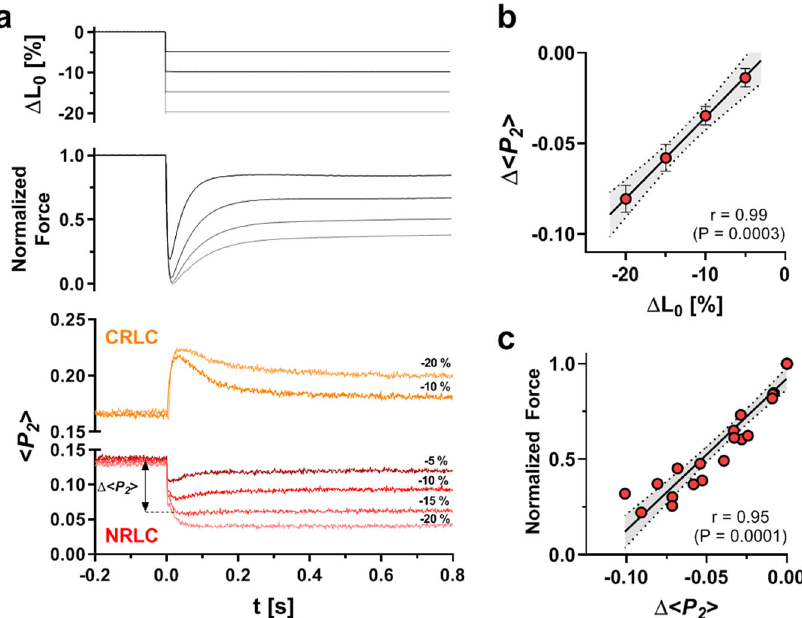
Fig. 3 Orientation changes of the NRLC and CRLC probe in response to shortening of Ca 2 + -activated muscle. a Upper panel: muscle length change ( Δ L 0 ); middle panel: normalized force; bottom panel: < P 2 > from the NRLC (red) and CRLC probe (orange). b Length-dependence of the change in < P 2 > ( Δ < P 2 >) from NRLC measured at the end of the < P 2 > transient. Data are shown as means ± s.e.m. ( n = 5 for − 20% Δ L 0 and − 10% Δ L 0 ; and n = 4 for − 5% Δ L − 15% Δ L P 2 > change ( Δ < P 2 >) of NRLC versus normalized isometric force ( n = 23; pooled data from n = 5 0 and 0 ). c Plot of steady state < trabeculae). Solid line represents linear regression with 95% con fi dence interval indicated by dotted lines. Pearson correlation coef fi cient (r) and p value for a two-tailed student ’ s t test are shown on the bottom right. Source data are provided as a Source Data fi